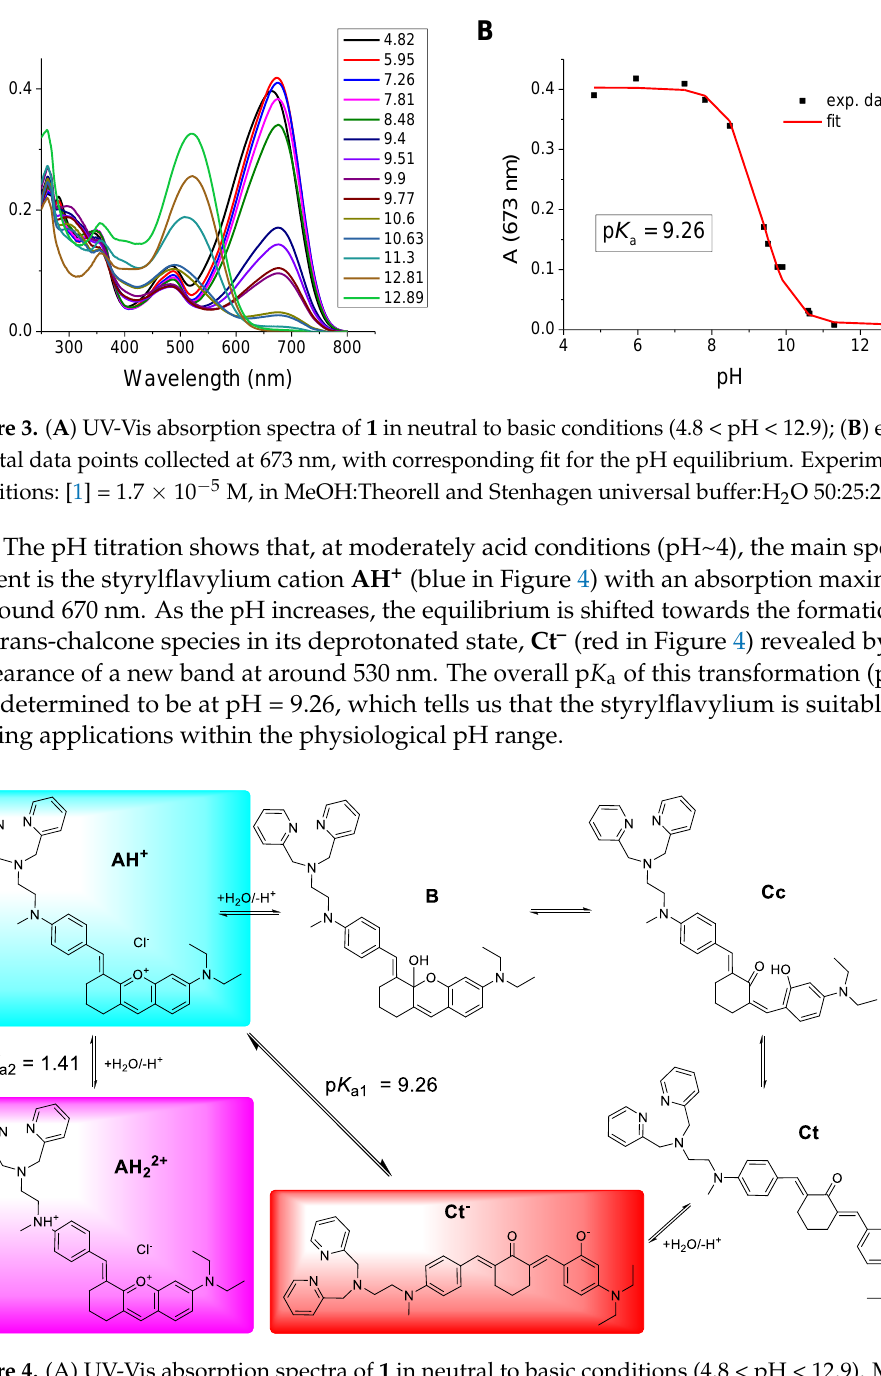
Figure 4. (A) UV-Vis absorption spectra of 1 in neutral to basic conditions (4.8 < pH < 12.9). Multi- state equilibria for 1, at different pH values. Styrylflavylium (AH+, blue) is stable in moderately acid to neutral pH.